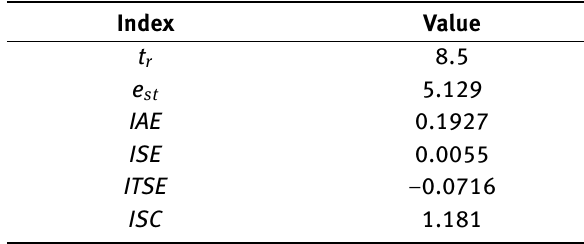
Table 4: Values of the performance